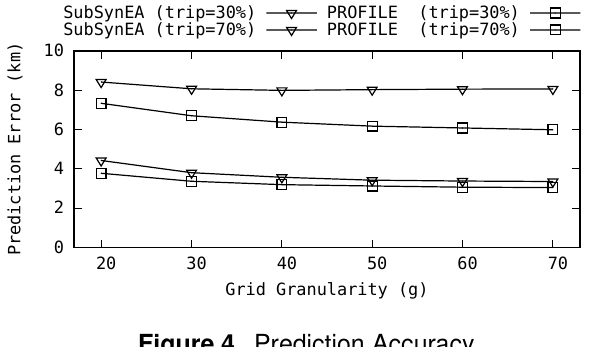
Figure 4. Prediction